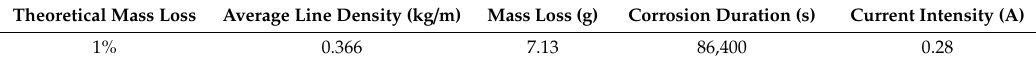
Table 2. Accelerated current value for theoretical steel mass loss.